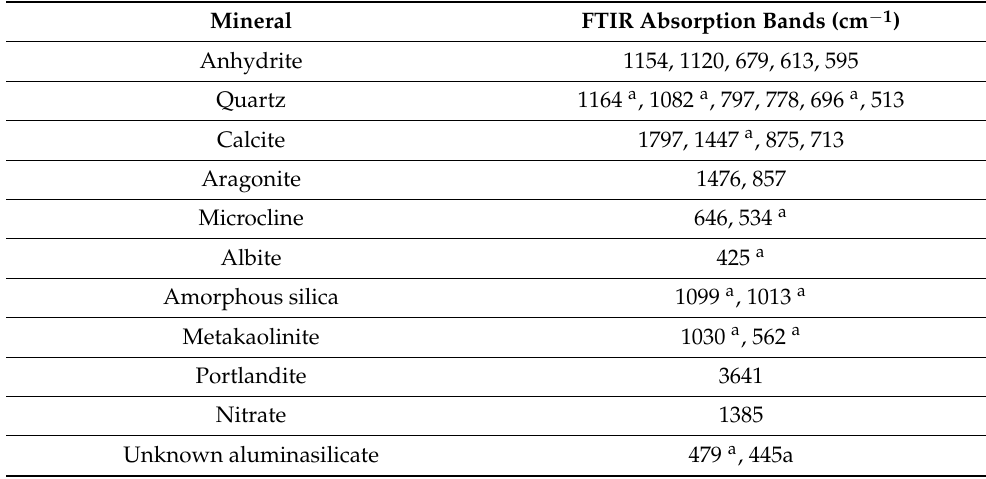
Table 6. FT-IR absorption bands of mineral matter in coal samples